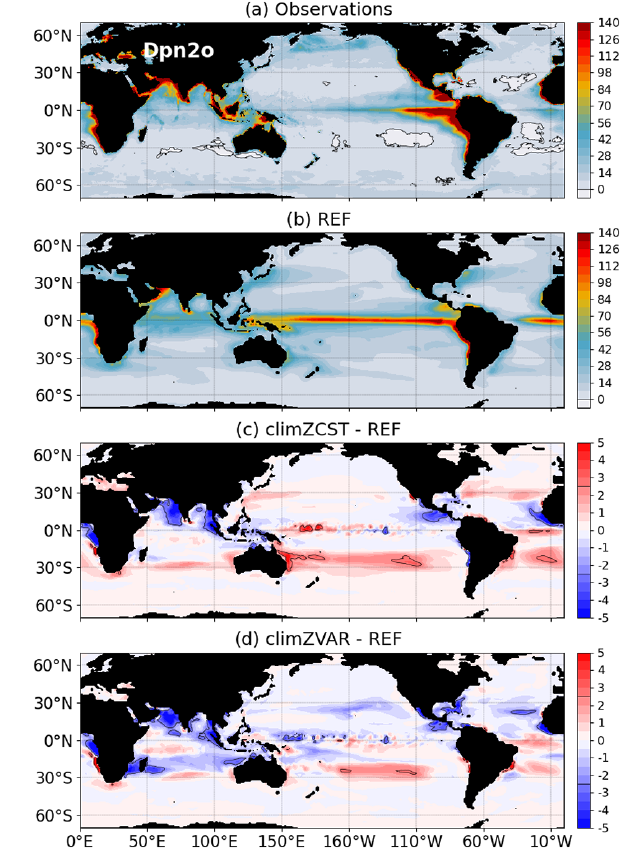
Figure 7. Mean sea-to-air Dpn2o (natm) computed from (a) obser- vations and (b) REF over the 2009–2018 period and its differences in relation to (c) climZCST and (d)